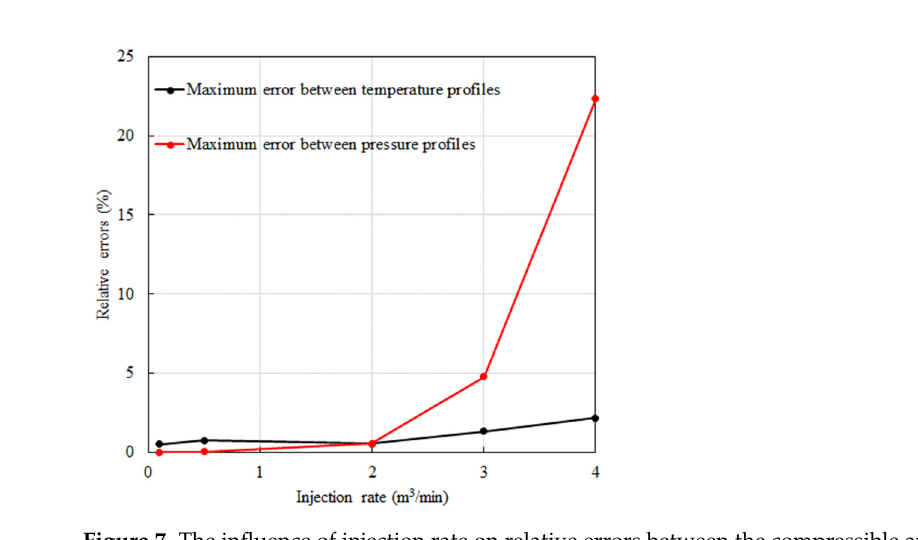
Figure 7. The influence of injection rate on relative errors between the compressible and incompress- ible flow.